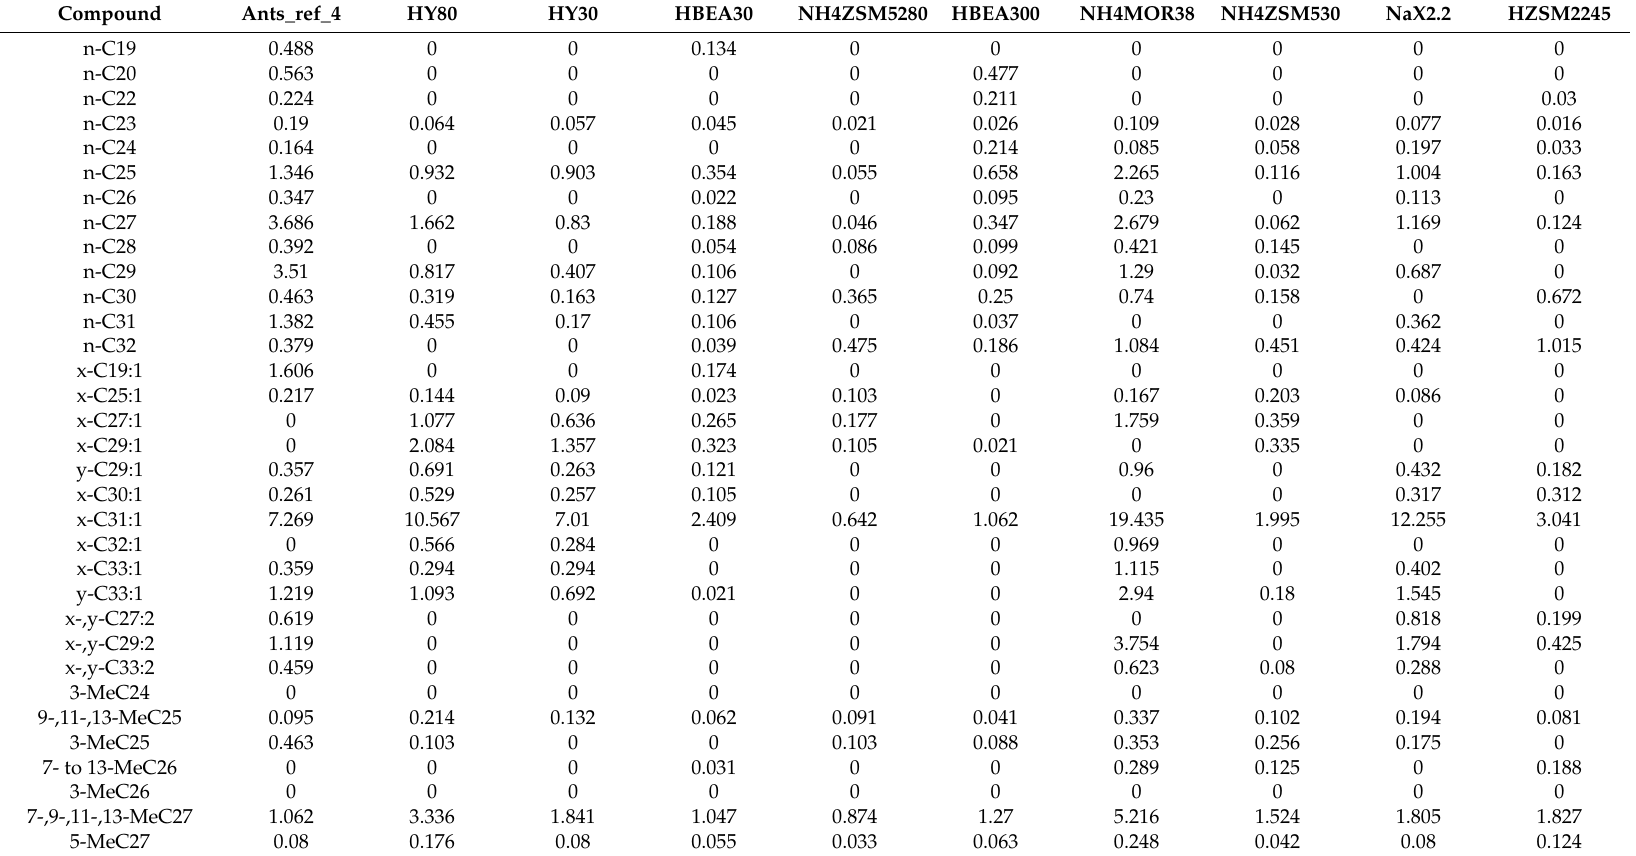
Table A1. Full dataset of compounds (in µ g/500 µ L injected sample) obtained by GC-MS analysis for the hexane wash of the foragers (ants_ref_4) and the hexane extracts of the powdered zeolite samples exposed to the M. pharaonis foragers. For plotting purposes (Figure 2), compounds which were not recovered (0 µ g/500 µ L) were assigned a value of 0.001 µ g/500 µ L (roughly 10% of the detection